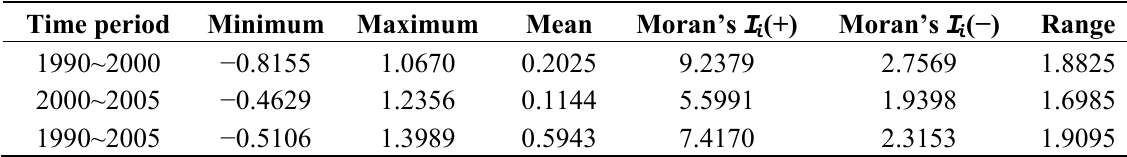
Table 3. Related parameters of the local Moran’s I for ecological land change in the Poyang Lake Eco-economic Zone from 1990 to